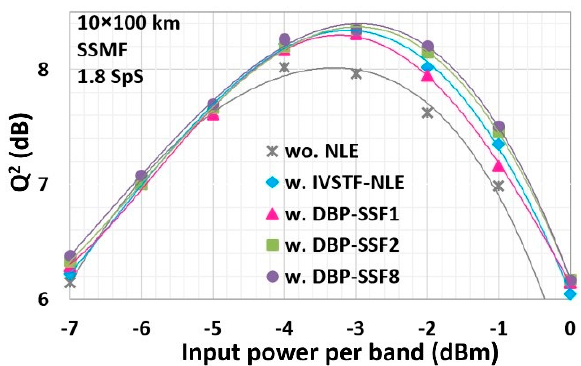
Figure 6. Simulation results on Q 2 -factor vs. input power per band without/with IVSTF-NLE and DBP-SSF 1,2,8 NLEs for the 3rd-band of the central OFDM in a WDM system with three wavelengths, 4-band DP-16QAM OFDM super-channels after 10 × 100 km of SSMF.